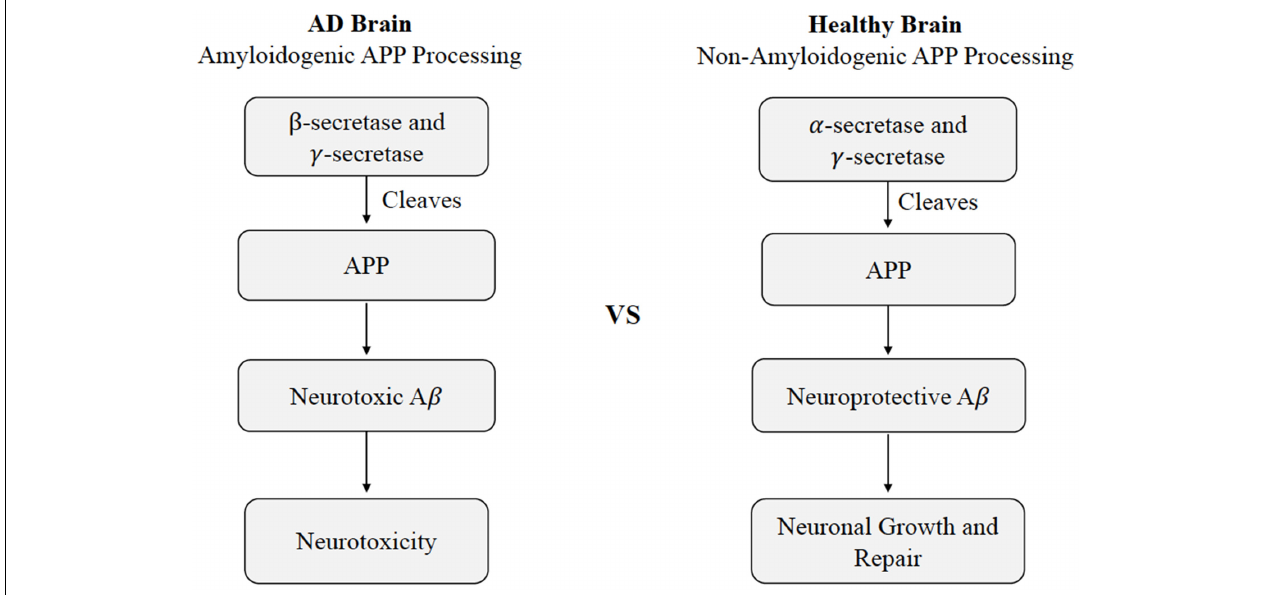
FIGURE 1 | Cleavage of APP in healthy vs. Alzheimer’s disease states. Differences in non-amyloidogenic cleavage of APP in a healthy brain compared to amyloidogenic cleavage of APP AD brain. In a healthy brain, APP is cleaved by γ -secretase and γ -secretase to produce neuroprotective A β , leading to neuronal growth and repair. In an AD brain, APP is cleaved by A β β - and γ -secretase, leading to neurotoxicity. Abbreviations: APP, amyloid precursor protein; AD, Alzheimer’s disease; A β , amyloid beta.